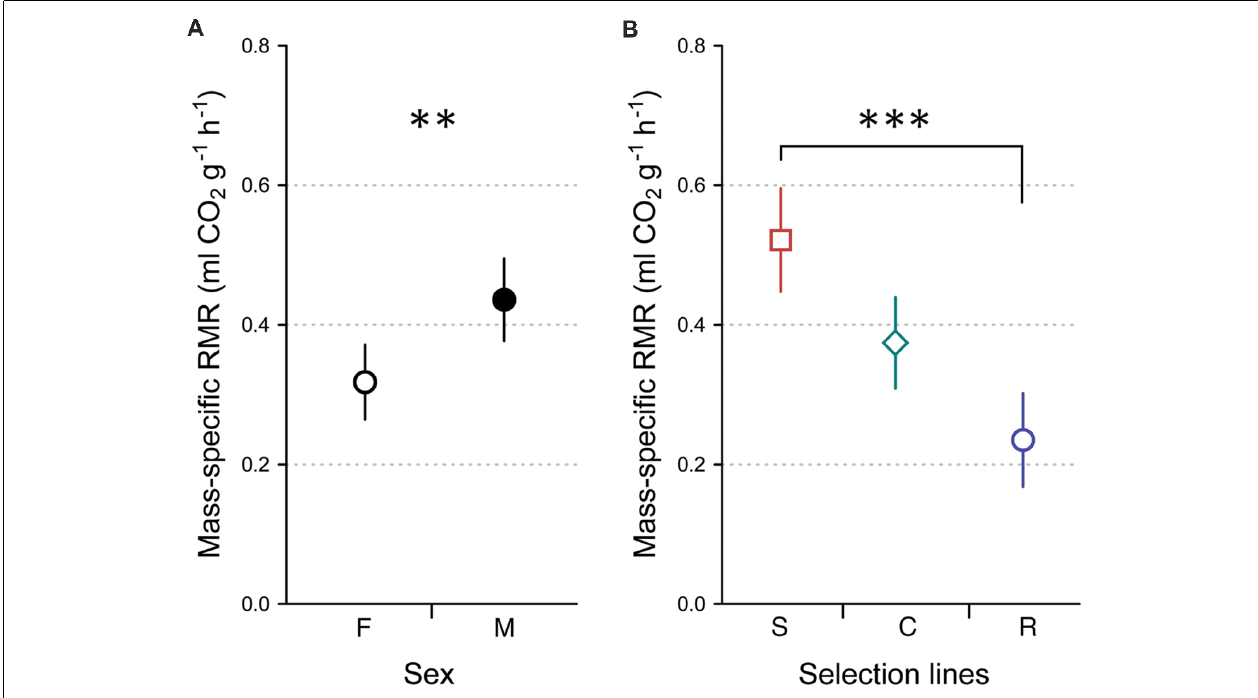
FIGURE 2 | Mass-specific resting metabolic rate (RMR) of females (F, open circle, n = 45) and males (M, closed circle, n = 38; A ), selected for slow development (squares, n = 24), rapid development (circles, n = 29) and control developmental (diamonds, n = 30; B ) lines. Symbols and error bars show averages and 95% CIs, respectively. Asterisks indicate significant differences ( ∗∗ P < 0.01; ∗∗∗ P < 0.001).